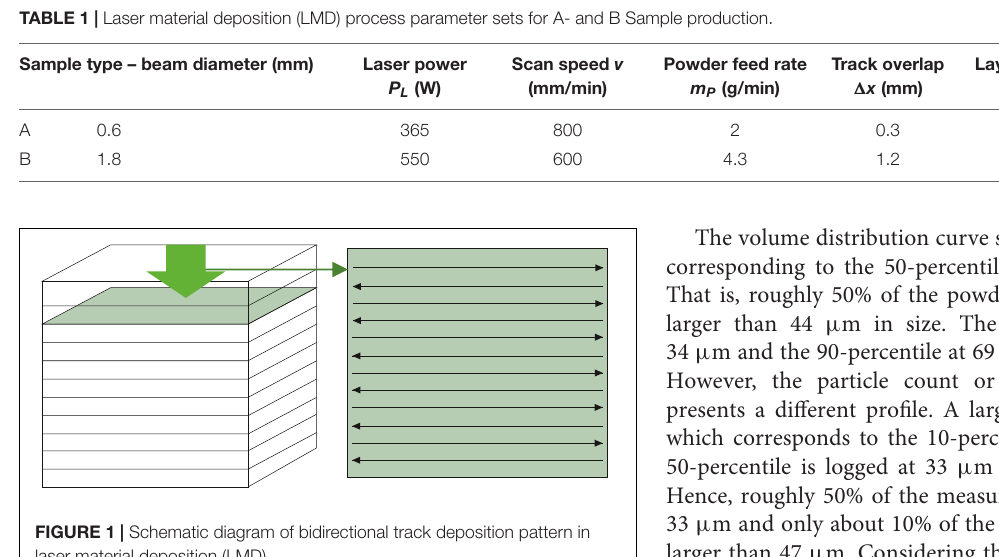
microscopy (SEM) system prior and after heat treatment. SEM analysis was only performed on samples fabricated with the final selected process parameter window for both sample